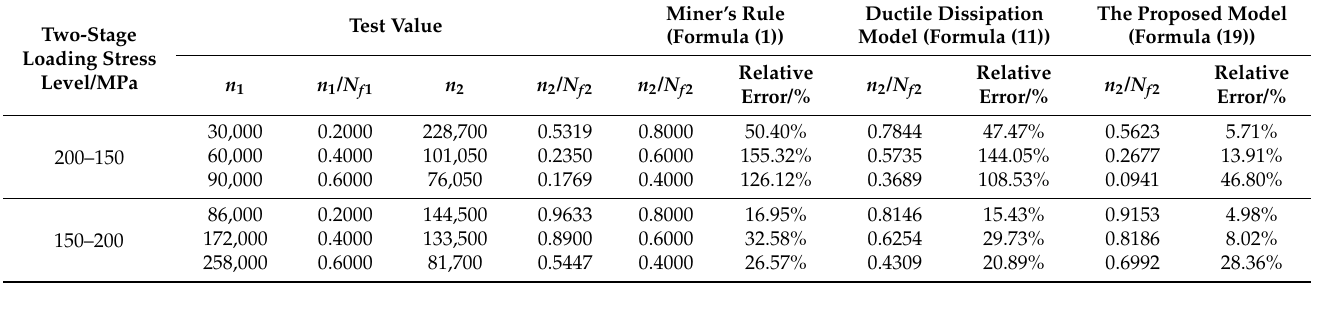
Table 4. 18CrNiMo7-6 two-stage loading test data and the remaining life prediction results of each model.